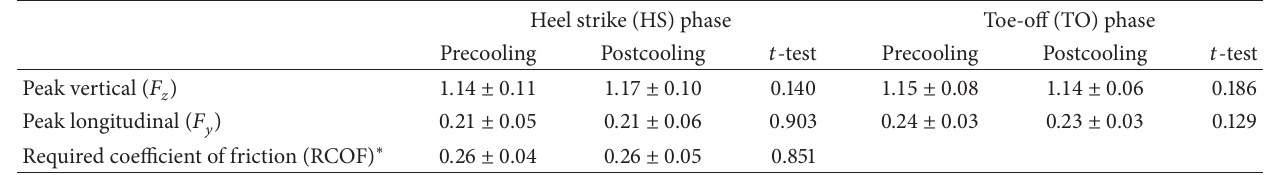
Table 2: Vertical and longitudinal GRFs (normalized by body weight in Newton) (mean ± SD) during heel strike and toe-off in relation to DF and PF, respectively, and RCOF before and after cooling ( 𝑛 = 16